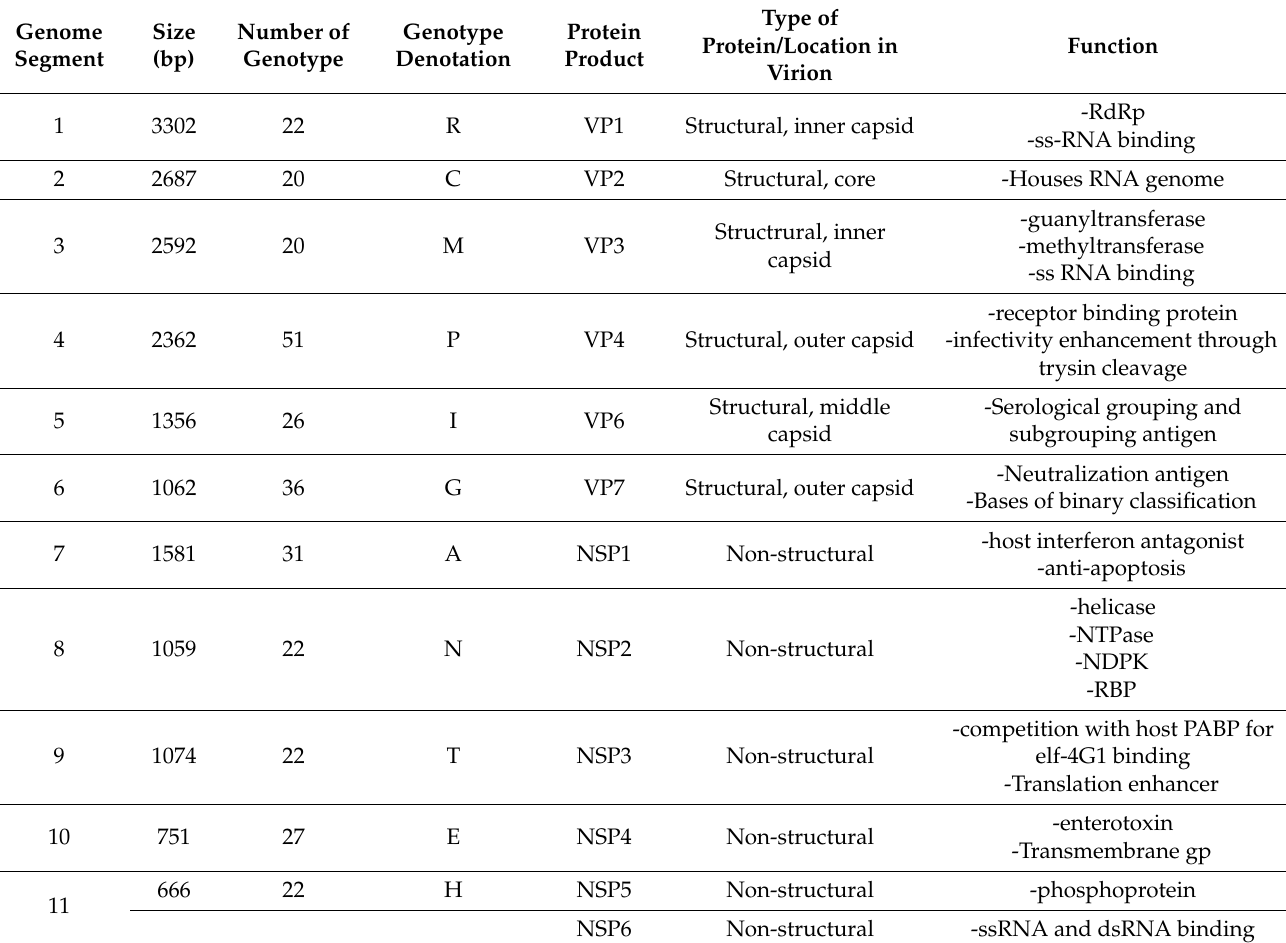
Figure 1. Schematic representation of the rotavirus virion [24]. Table 1. The number of genotypes ascribed to each gene segment (updated) and the biological functions of their encoded proteins [25,26].